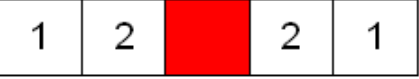
Figure 4. Diagram of the weight values.